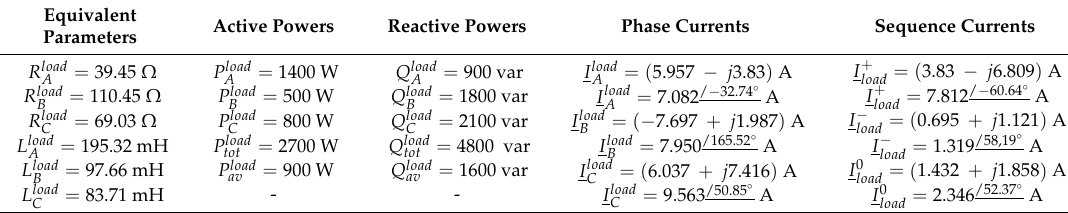
Table 1. Unbalanced three-phase load—values valid for both compensators.